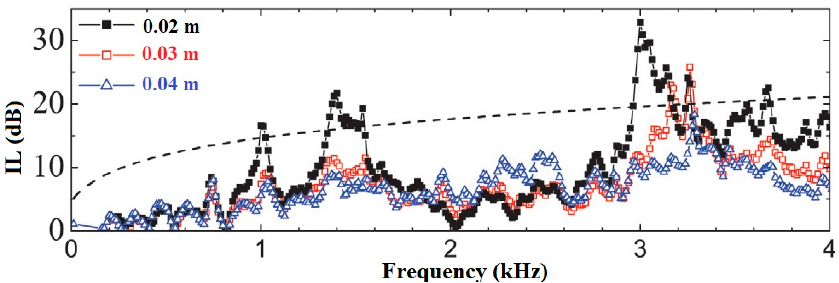
Figure 9. Insertion loss for a standard barrier (dashed line) and sonic crystals with a porous shell of different thicknesses, modified from